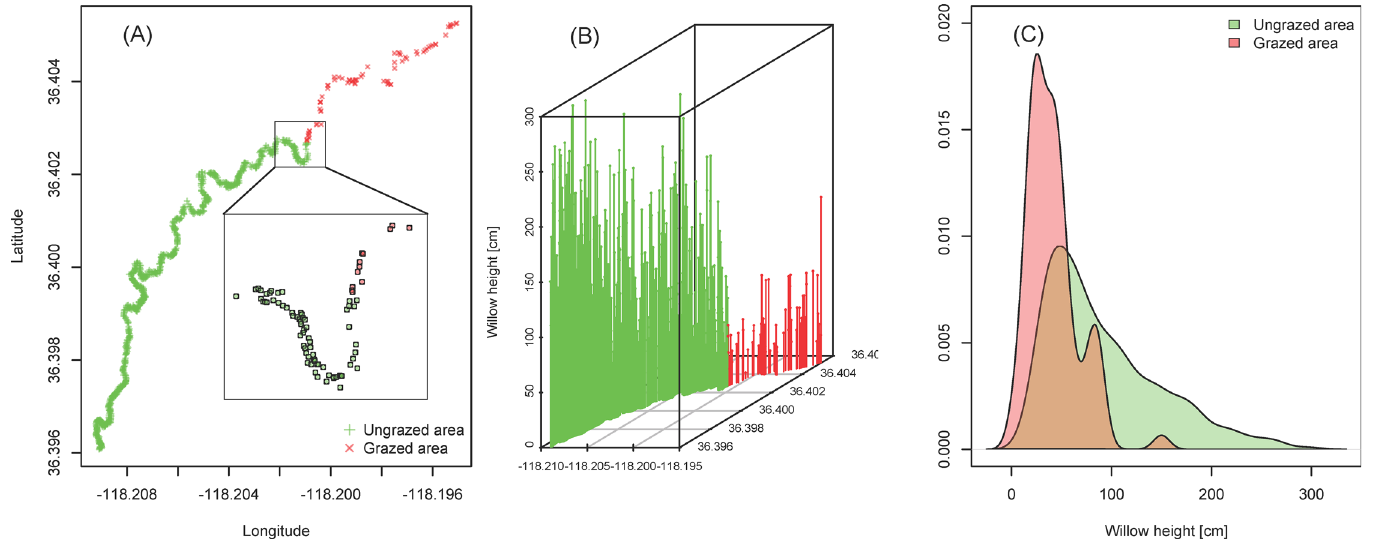
Fig 3. Willow height and concentration. (A) Willow location along the riverbank, with increased definition inside the inset box. (B) Individual willow heights [cm] and concentration along the riverbank with a view from the side. (C) Kernel density estimation for the willow height distribution [cm]. For each panel, green coloration represents the ungrazed area inside the cattle exclosure, and red coloration represents the area outside the exclosure in the grazed area.